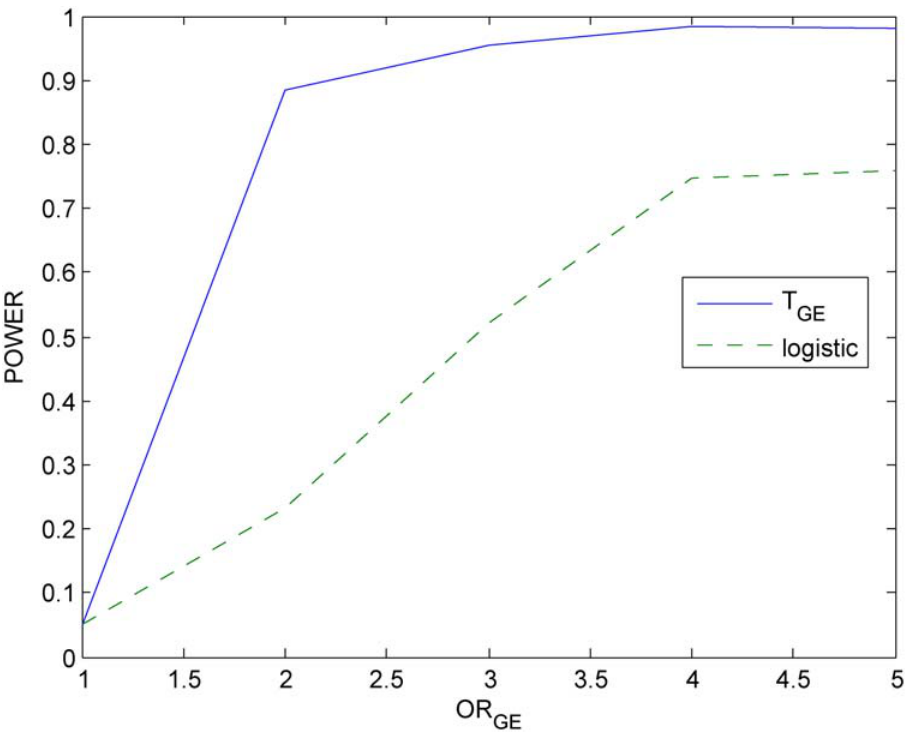
Figure 8. Power of the statistic T I and logistic regression analysis for sample size 300, OR G ~ 2 and OR E ~ 2 .